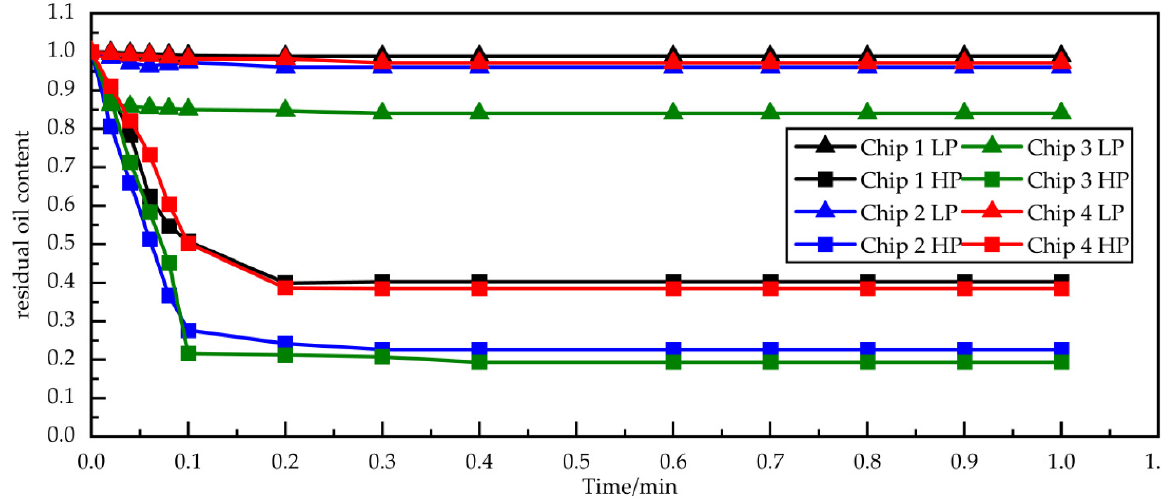
Figure 5. Residual oil volume versus time in high and low permeable zones in non-homogeneous porous media. LP represents low permeable zone, HP represents high permeable zone.